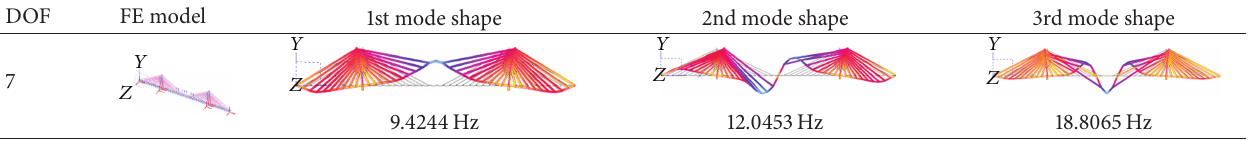
Table 7: Frequency and mode shape of 7 DOF using KEOT.